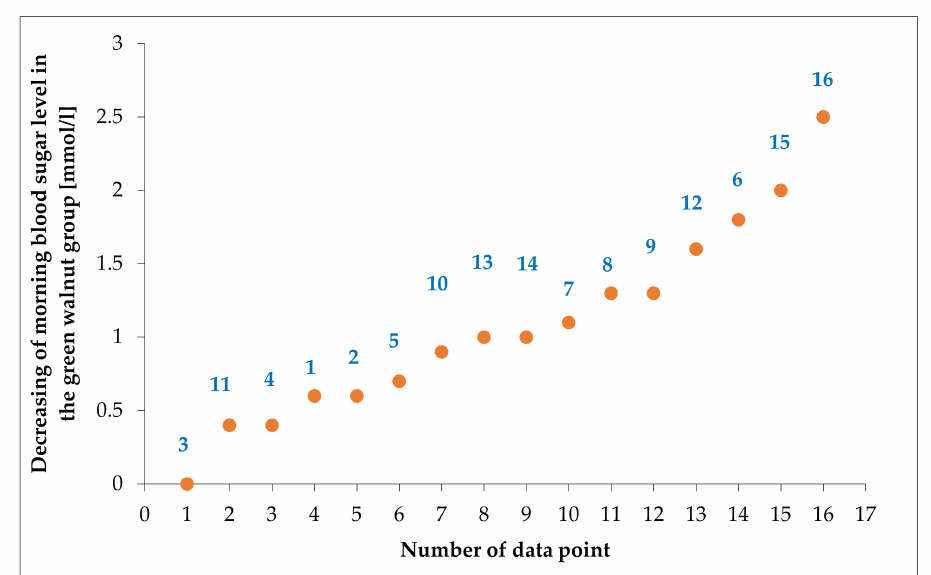
Figure 3. The decrease of morning blood sugar values in the blood of volunteers in treatment group 4. The data were presented in ascending order and calculated by subtraction of the morning blood sugar value measured on the 21st day of the trial from day 0 of the